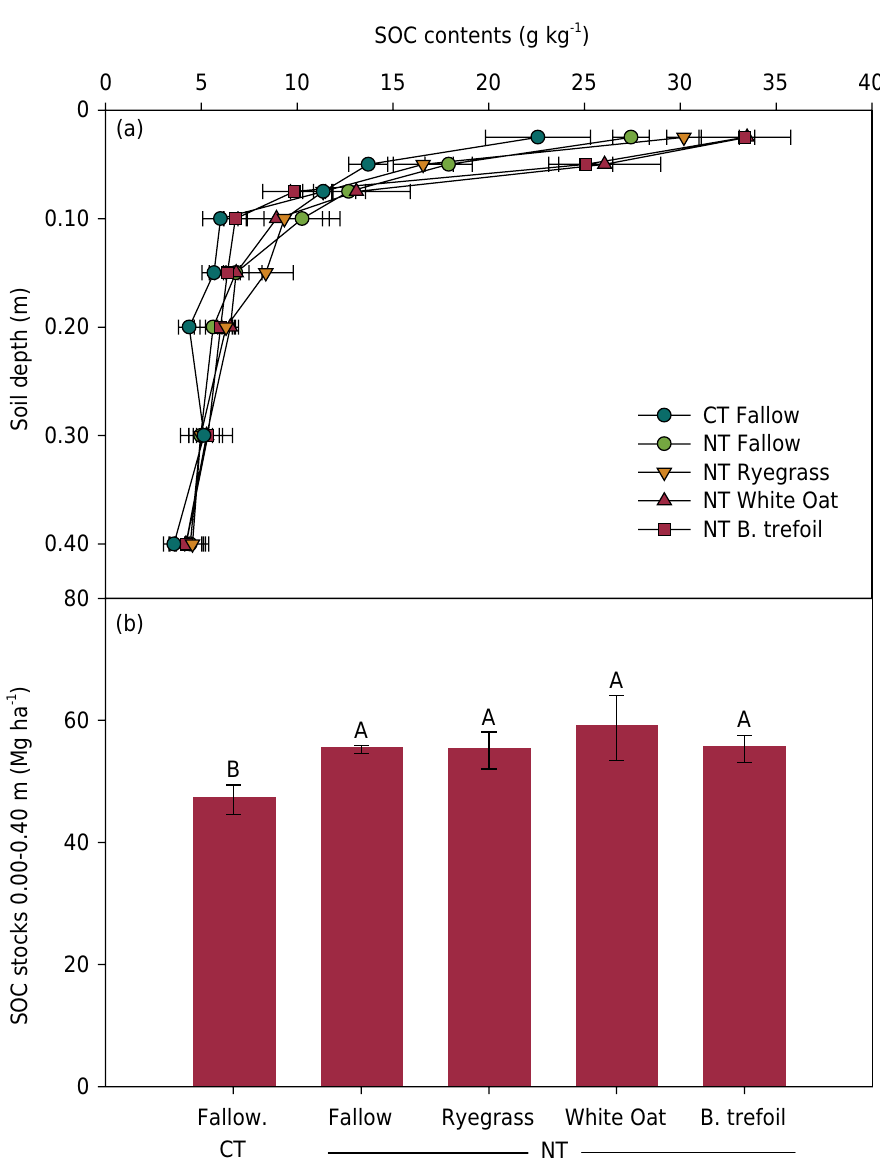
Figura 2. Soil organic C (SOC) contents in soil profile (a) and stocks at 0.00-0.40 m soil layer (b) of a Gleysol subjected to different soil winter managements (fallow or cover crops) combined with conventional tillage (CT) or no-tillage (NT) in southern Brazil. Vertical lines denote the standard deviation. Different letters on the bars indicate a significant difference between treatments by the Test of Skott-Knott at 5 % level. ns: no